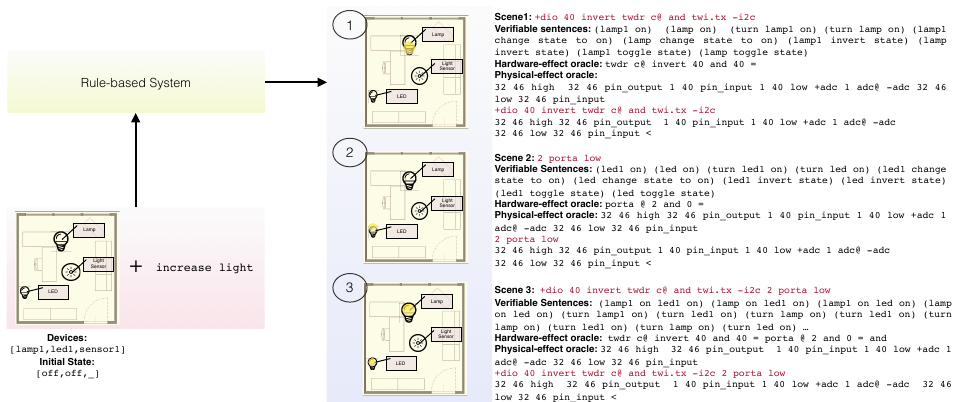
Figure 11. Given the set of hardware devices in the example, the initial state, and the high-level command increase light , the system generates three possible scenes. For each, all the verifiable sentences producing the same final state are also generated, along with the respective hardware-effect and physical-effect